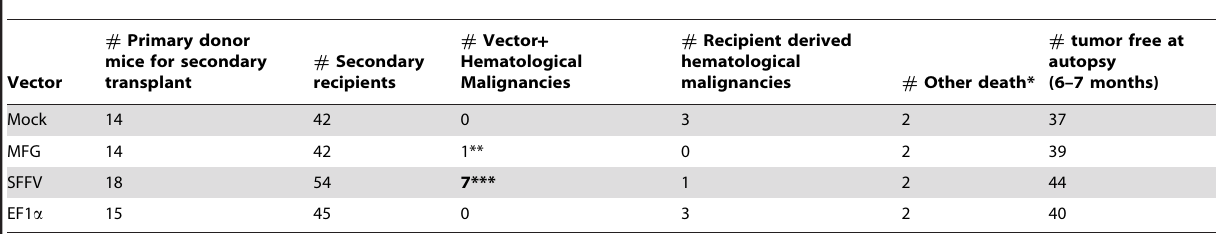
Table 4. Malignancy incidence in secondary recipient mice in Exp 2 (Donor: CD45.1 + ; Recipient: CD45.2 + ).